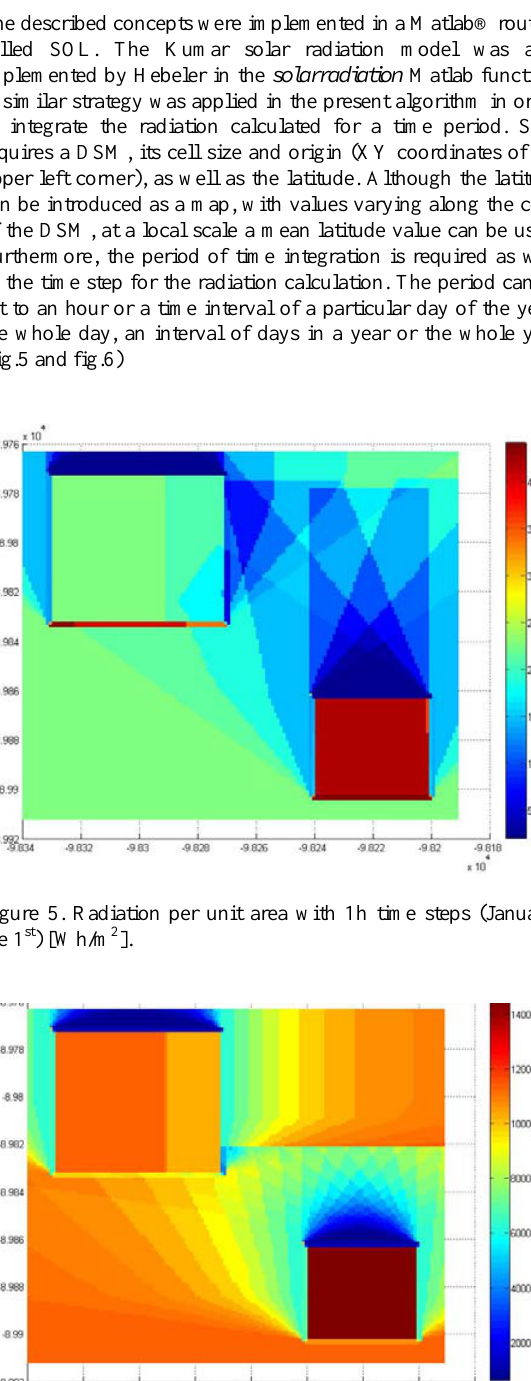
Figure 8. 3D Solar Radiation Model for June, the 6 th , 9 a.m showing the shadows and the sun energy per square meter. Model based on LiDAR